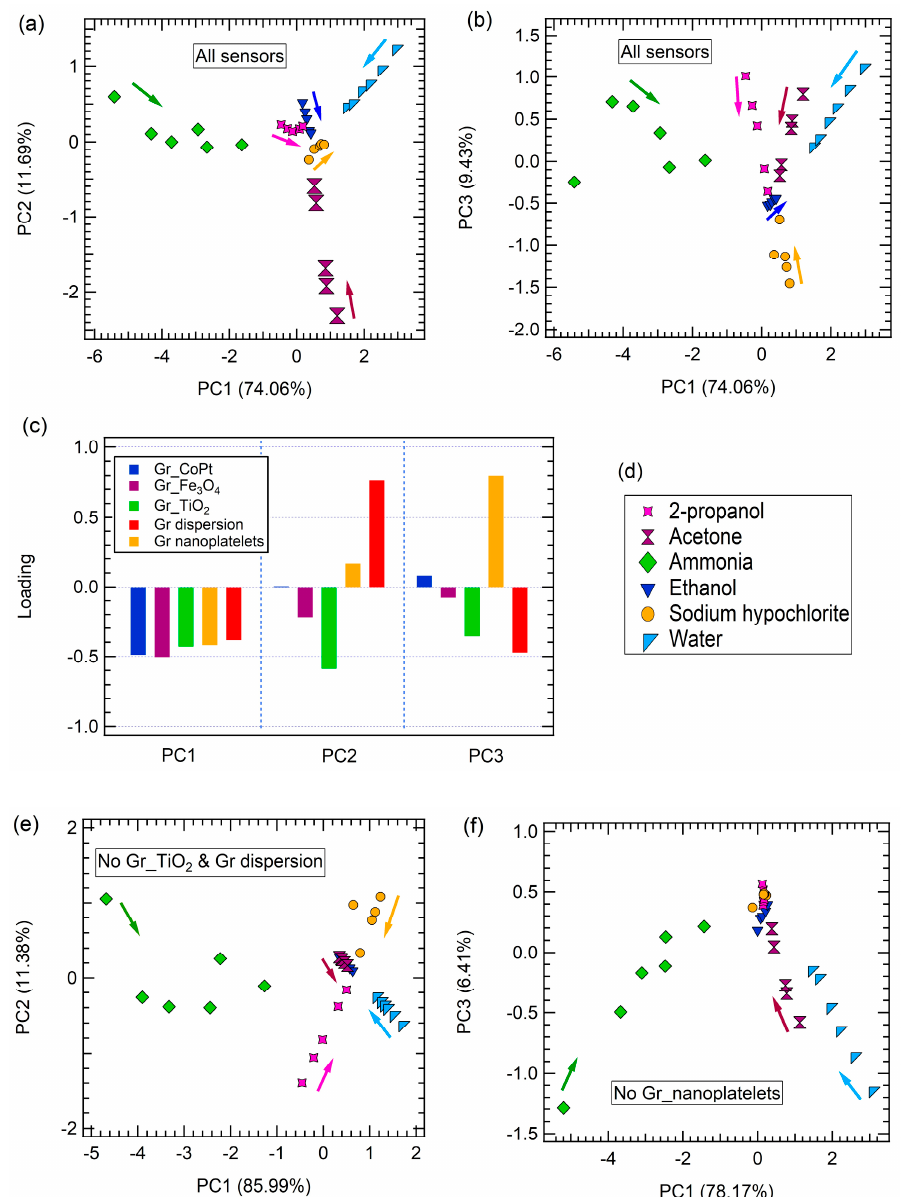
Figure 5. The PCA of the sensor array responses to exposure to ammonia, water, acetone, ethanol, and 2-propanol concentrations, performed considering all sensors: ( a ) PC2 vs. PC1, ( b ) PC3 vs. PC1, ( c ) loadings on PC1, PC2, and PC3, ( d ) legend of PCA contributions, ( e ) PCA result carried out without Gr dispersion and Gr_TiO 2 sensors contributions, and ( f ) PCA space obtained without Gr_nanoplatelets sensor contribution. The arrows indicate the decreasing concentration